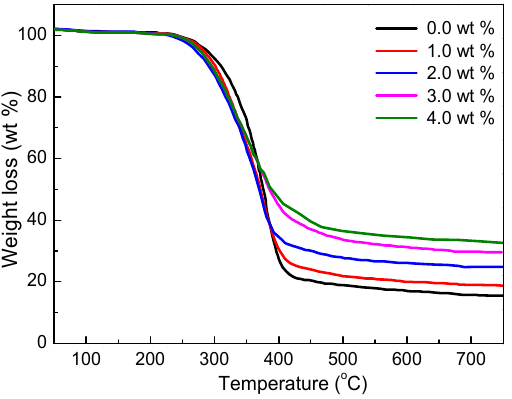
Figure 4. TG curves of polymer composite coatings filled with various grapheme contents.